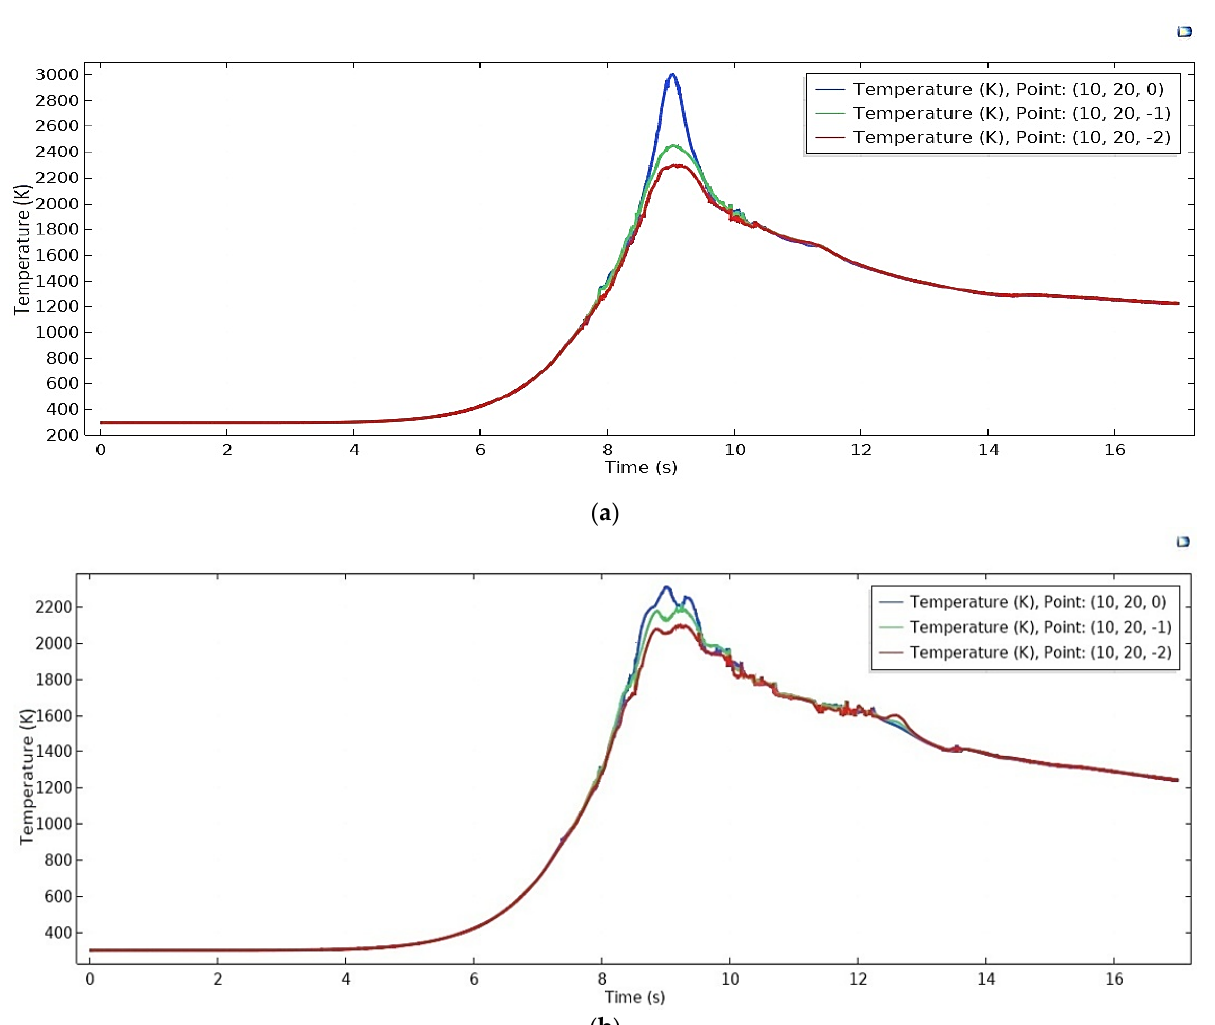
Figure 16. Temperature distribution of three different points on interface: ( a ) 0.3 mm offset and ( b ) 0.6 mm offset toward Ti6Al4V.